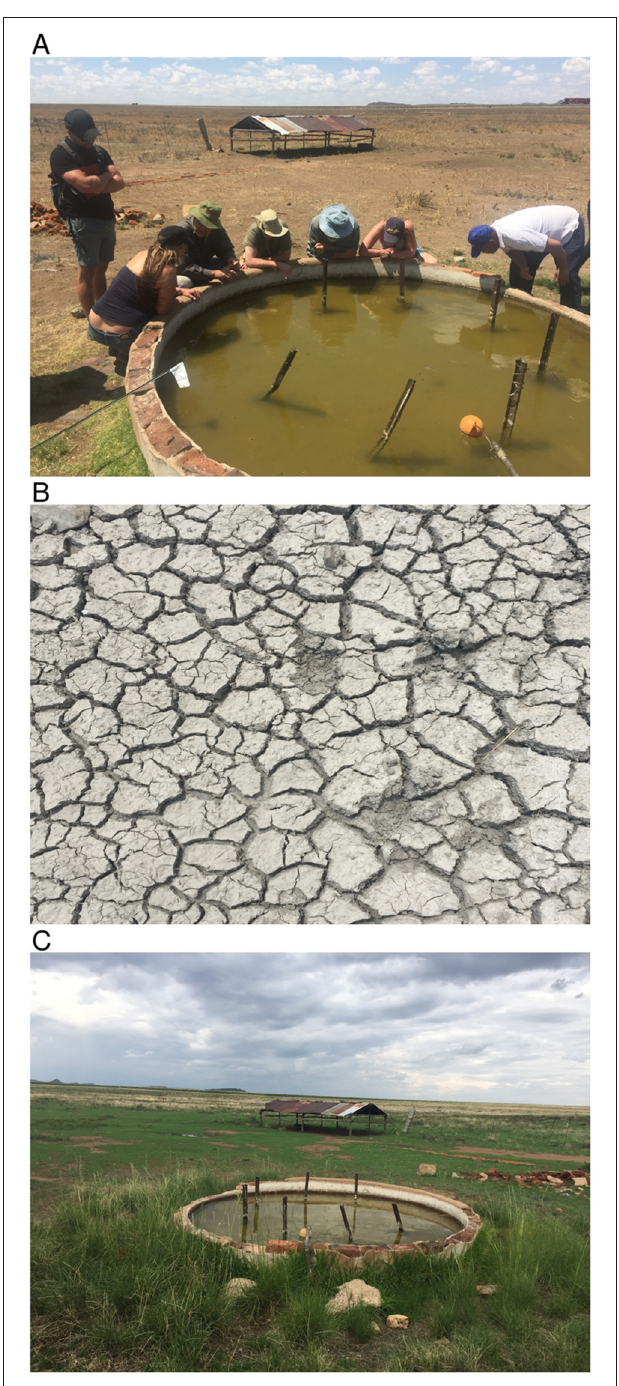
FIGURE 4 | Contrasting conditions in and around Meadows pan habitat (location shown in Supplementary Figure 1 ). [ (A) -top] severe drought conditions in March 2016 at the peak of the growing season (rainfall total: ∼ 75.82mm, long-term mean: 109.65mm; normalized difference vegetation index: ∼ 0.28, long-term mean: 0.44; land surface temperature: 34.6 ◦ C, long-term mean: 31.9 ◦ C), [ (B) -middle], desiccated dambo/plan floor during the same time period, and [ (C) -bottom] March 2018: vegetation growth after sustained wet conditions (rainfall total: ∼ 182.80mm, long-term mean: 109.65mm; normalized difference vegetation index: ∼ 0.51, long-term mean: 0.44; land surface temperature: 28.04 ◦ C, long-term mean: 31.9 ◦